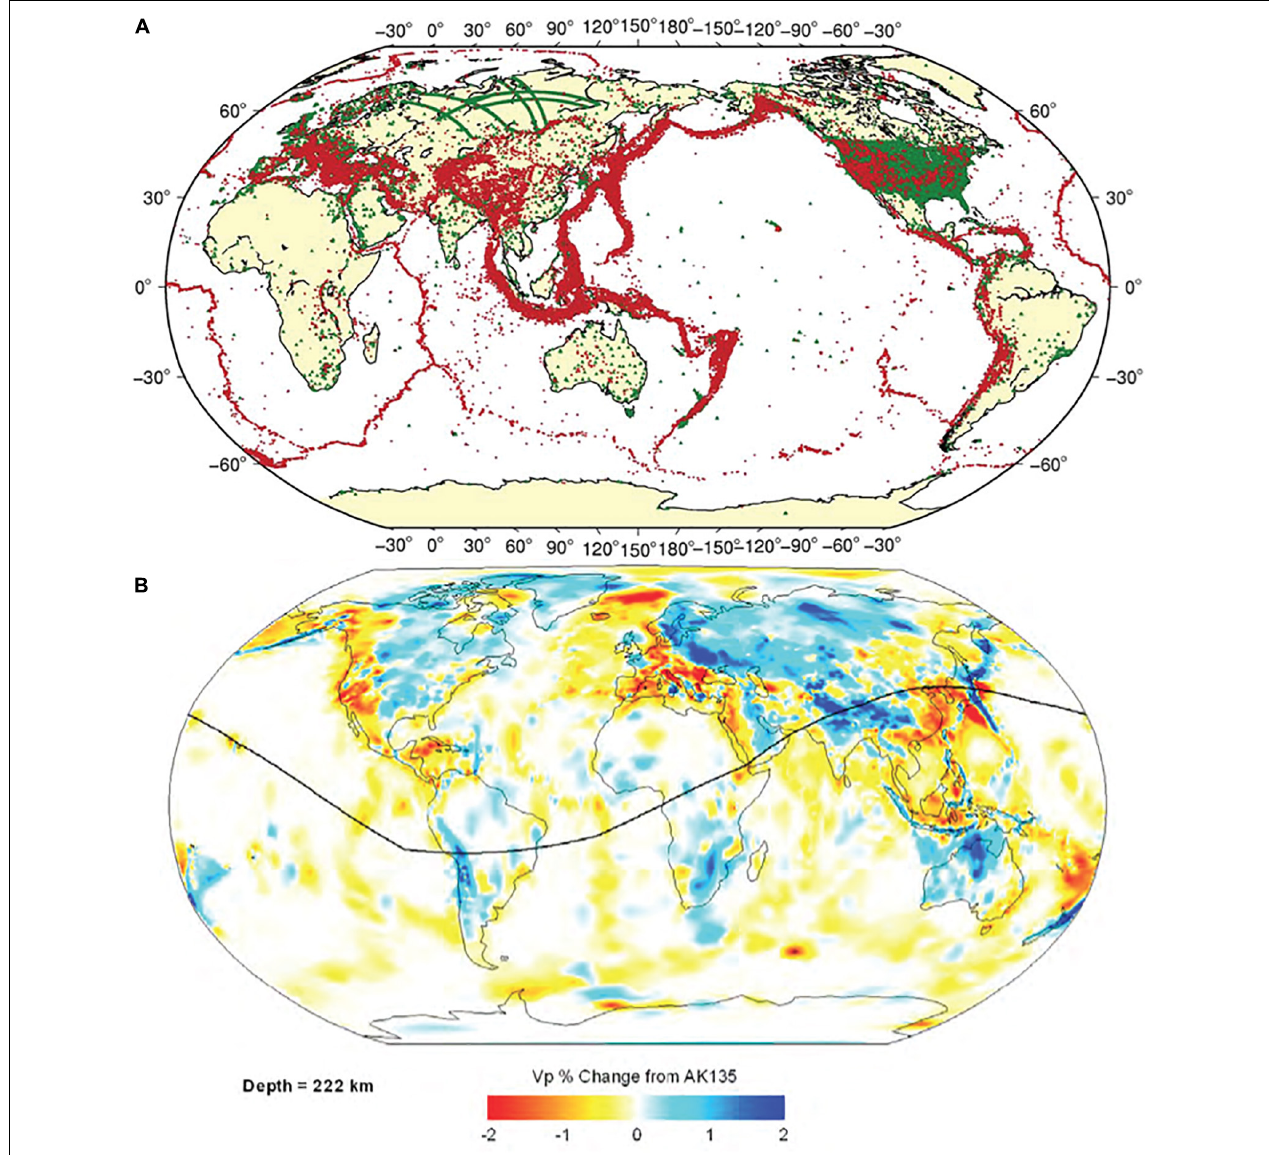
FIGURE 12 | (A) Distribution of global earthquakes (red) and existing seismic sensors (green) used in the derivation of the SALSA3D model. (B) Global seismic velocities at a 222 km depth in the 3D tomographic “SALSA3D” P-wave model shown as perturbation from the 1-D starting model (Begnaud et al., 2011; Ballard et al., 2016). Permission obtained for use of